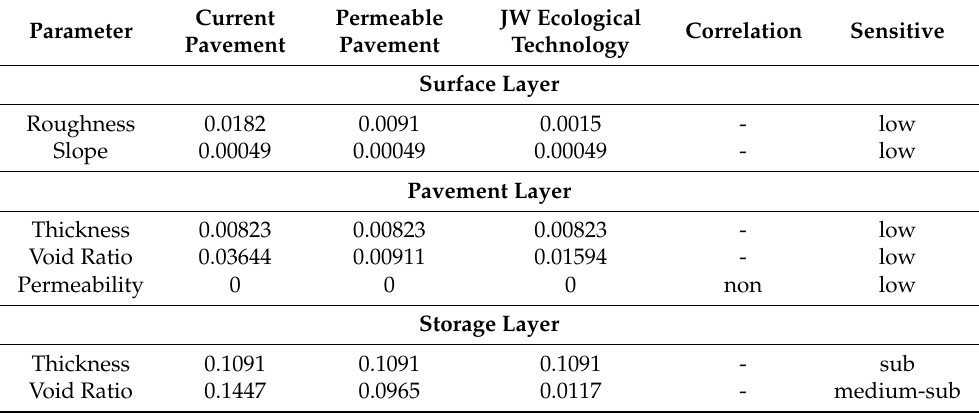
Table 5. SN value and sensitivity analysis results of the stormwater management model permeable pavement parameters to flood peak